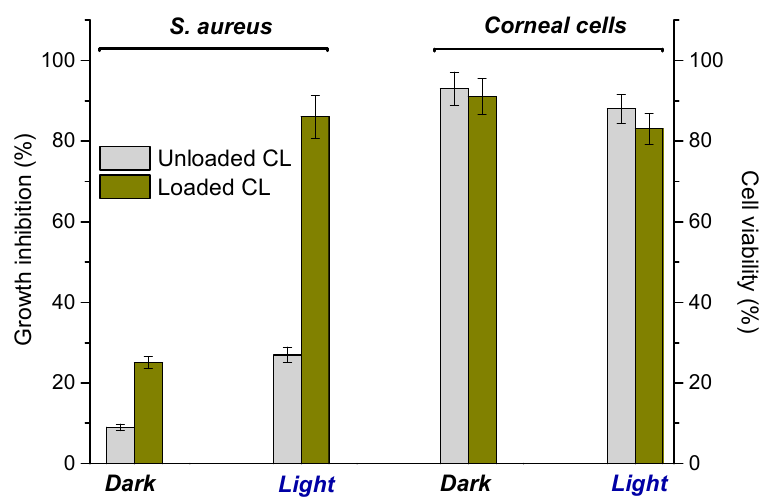
Figure 5. S. aureus growth inhibition and human corneal epithelial (HCE-2) cells viability of unloaded and loaded CL in the dark and upon illumination with visible light ( λ exc > 400 nm).